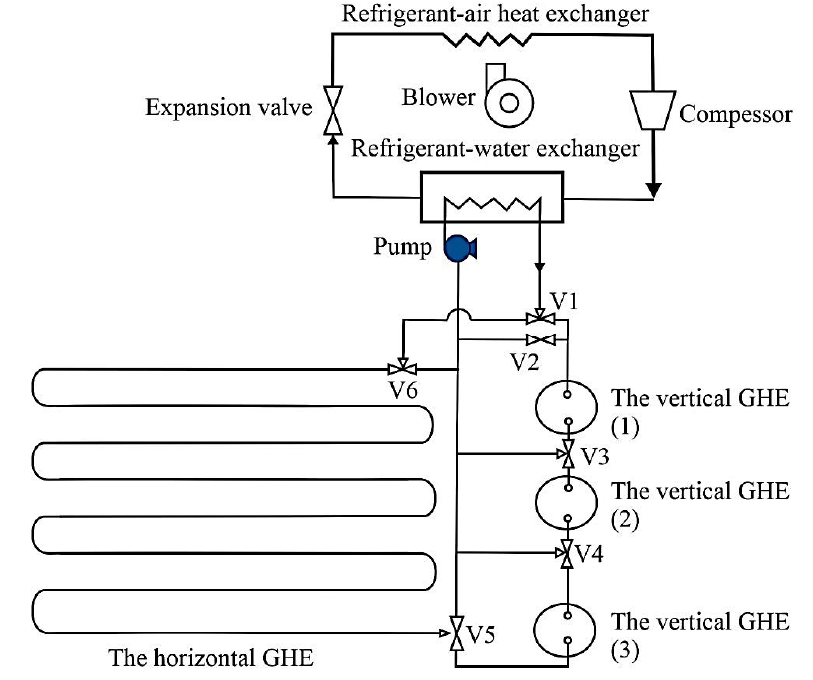
Figure 2. Schematic of the hybrid horizontal vertical GHE.